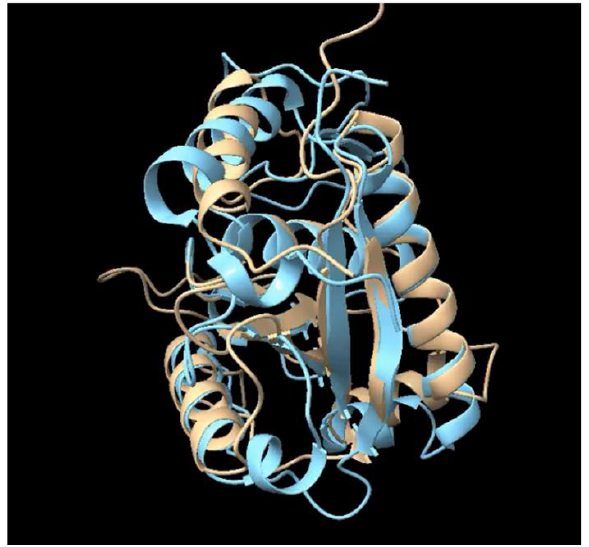
Figure 1. Metalloproteoid JAA55829.1 predicted Alphafold structure (Brown color) superimposed to the metalloprotease leucurolysin-a (PDB 4q1l-A) (Blue color). 2.1.2. Amb-25-357 Changed to Metalloproteoid, Amblyomma Koch, 1844 (Acari: Ixodi- dae)